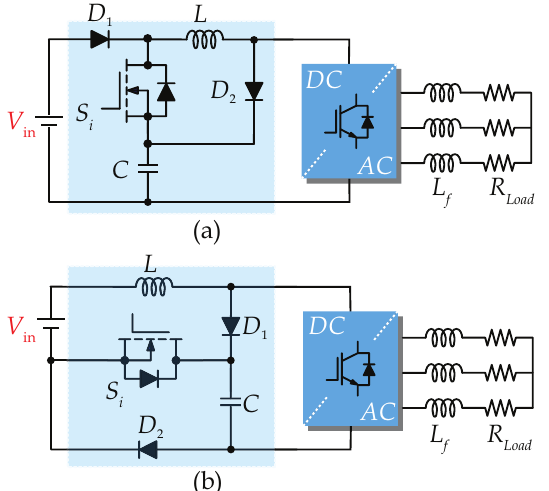
Figure 3. Impedance-source inverter with active power switches: ( a ) switched boost inverter (SBI) [13], and ( b ) embedded-qSBI [14].